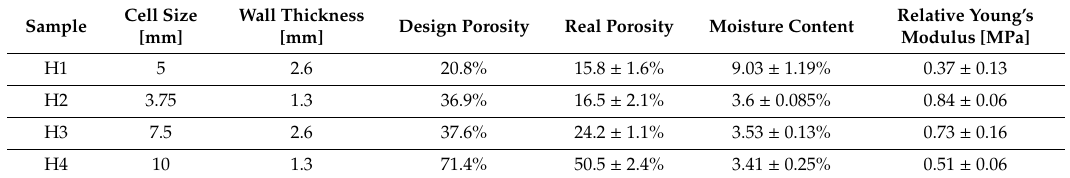
Table 5. Summary of samples characterized by X-ray µCT. For all samples, a reduction in porosity can be observed.